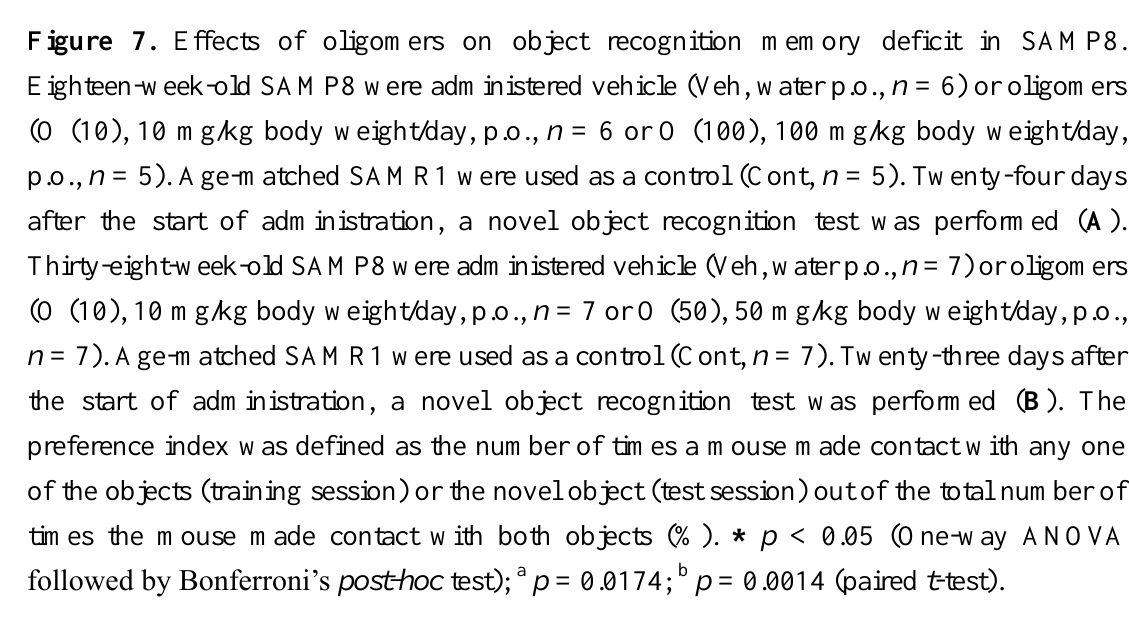
Figure 7. Effects of oligomers on object recognition memory deficit in